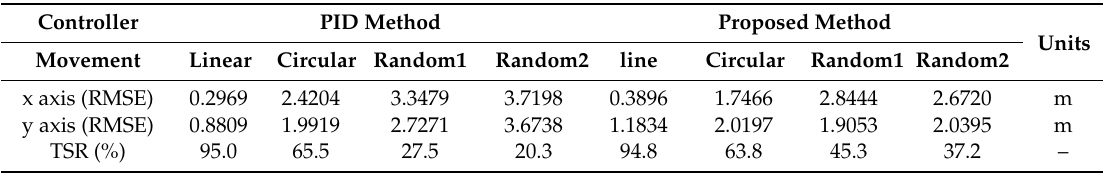
Table 3. Root-mean-square error and tracking success rate (TSR) of the unmanned aerial vehicle (UAV) for tracking a moving